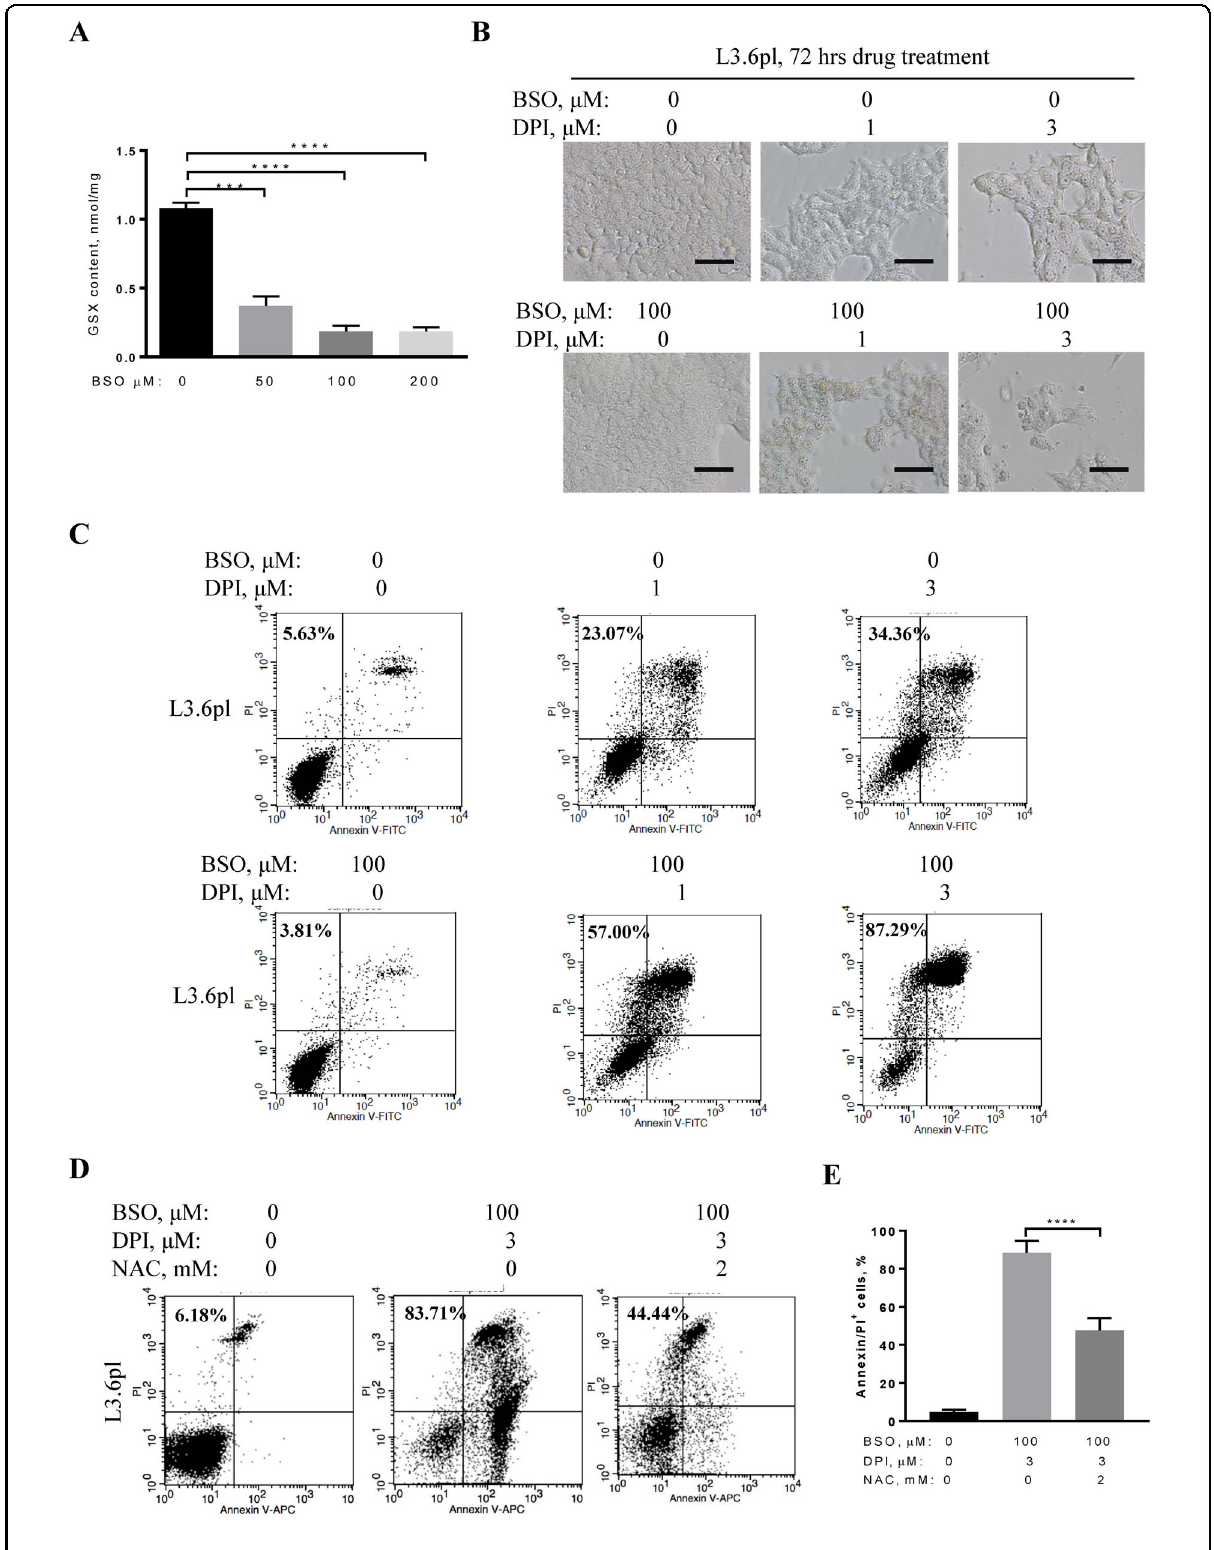
Fig. 2 (See legend on next